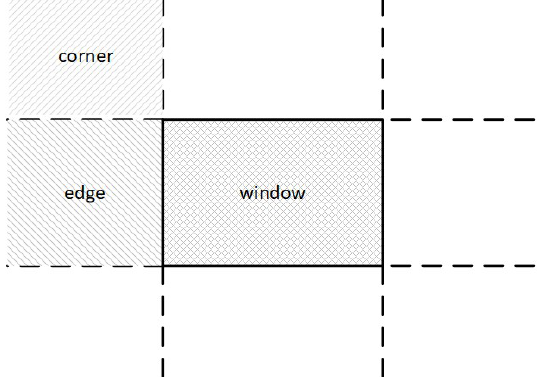
Figure 10. NLN uses only three out of nine regions namely window, edge and corner.